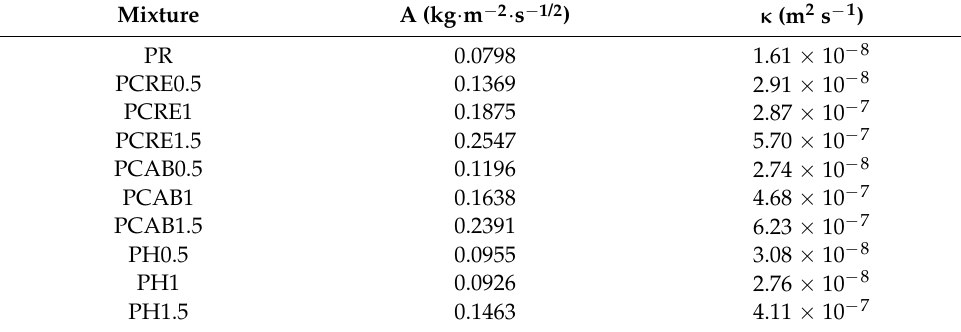
Table 5. Liquid water transport properties of studied